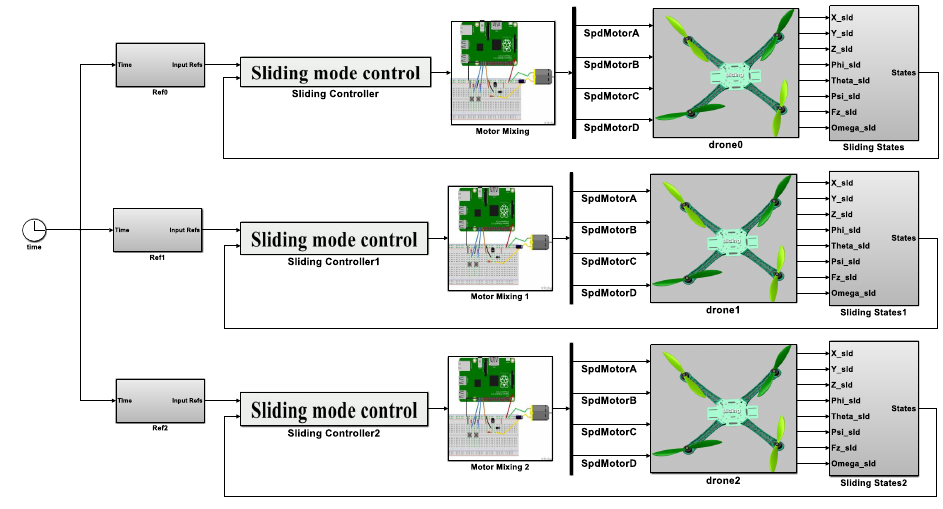
Figure 10. The simulation diagram of three drones in a swarm